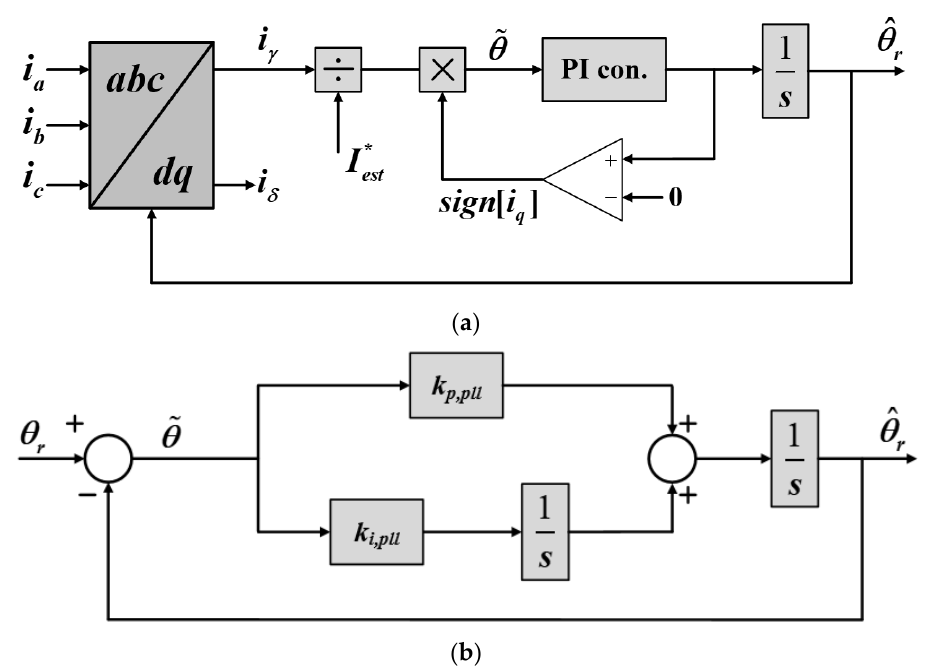
Figure 1. Structure of the position and speed estimation system. ( a ) Actual block diagram of the estimator and ( b ) equivalent block diagram of the actual estimator.